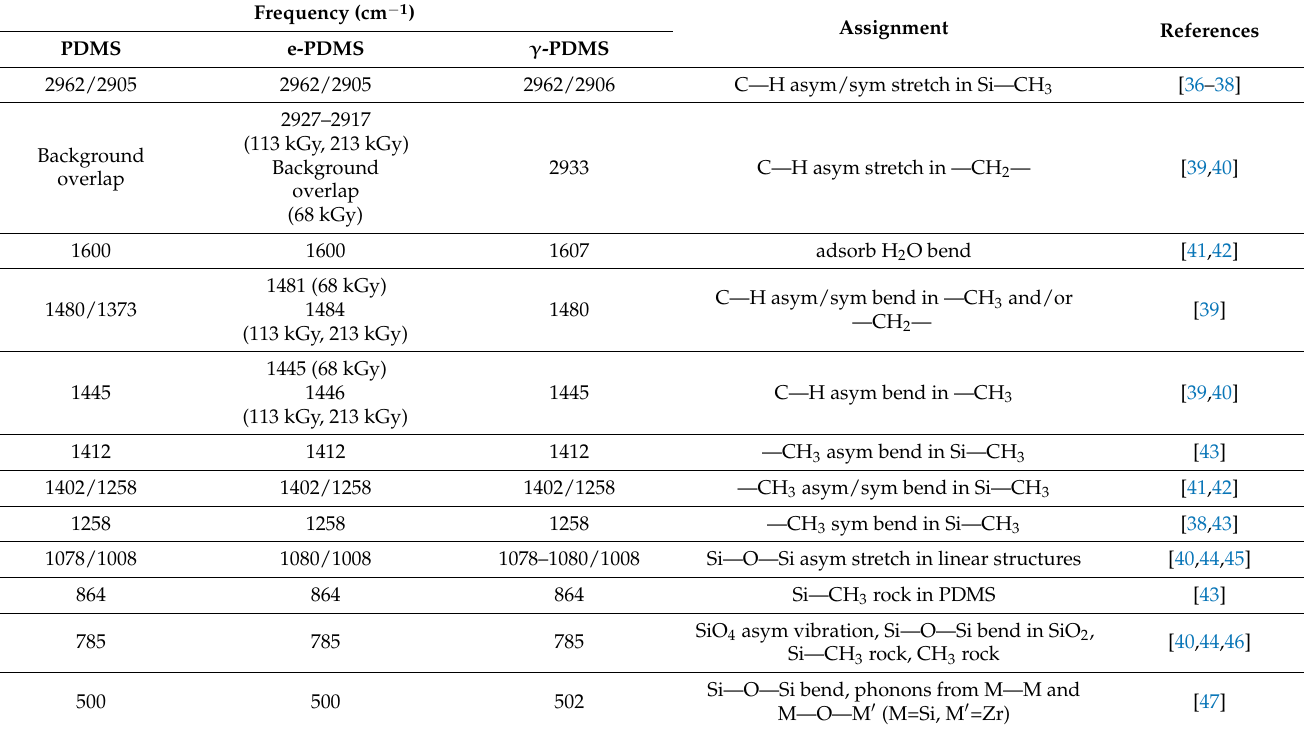
Table 5. Assignment of FTIR bands for PDMS before and after